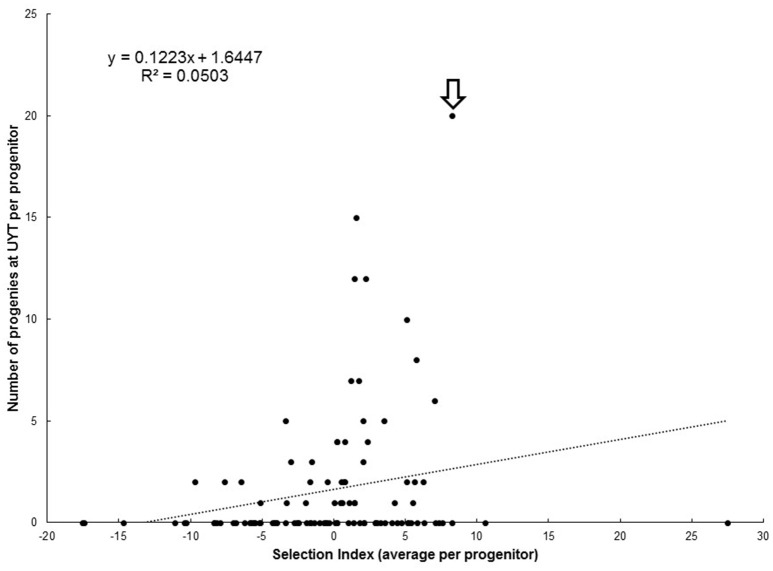
Relationship between average selection index (SIN) of each progenitor with the respective number of clones representing them at UYT (arrow identifies SM 1411-5).